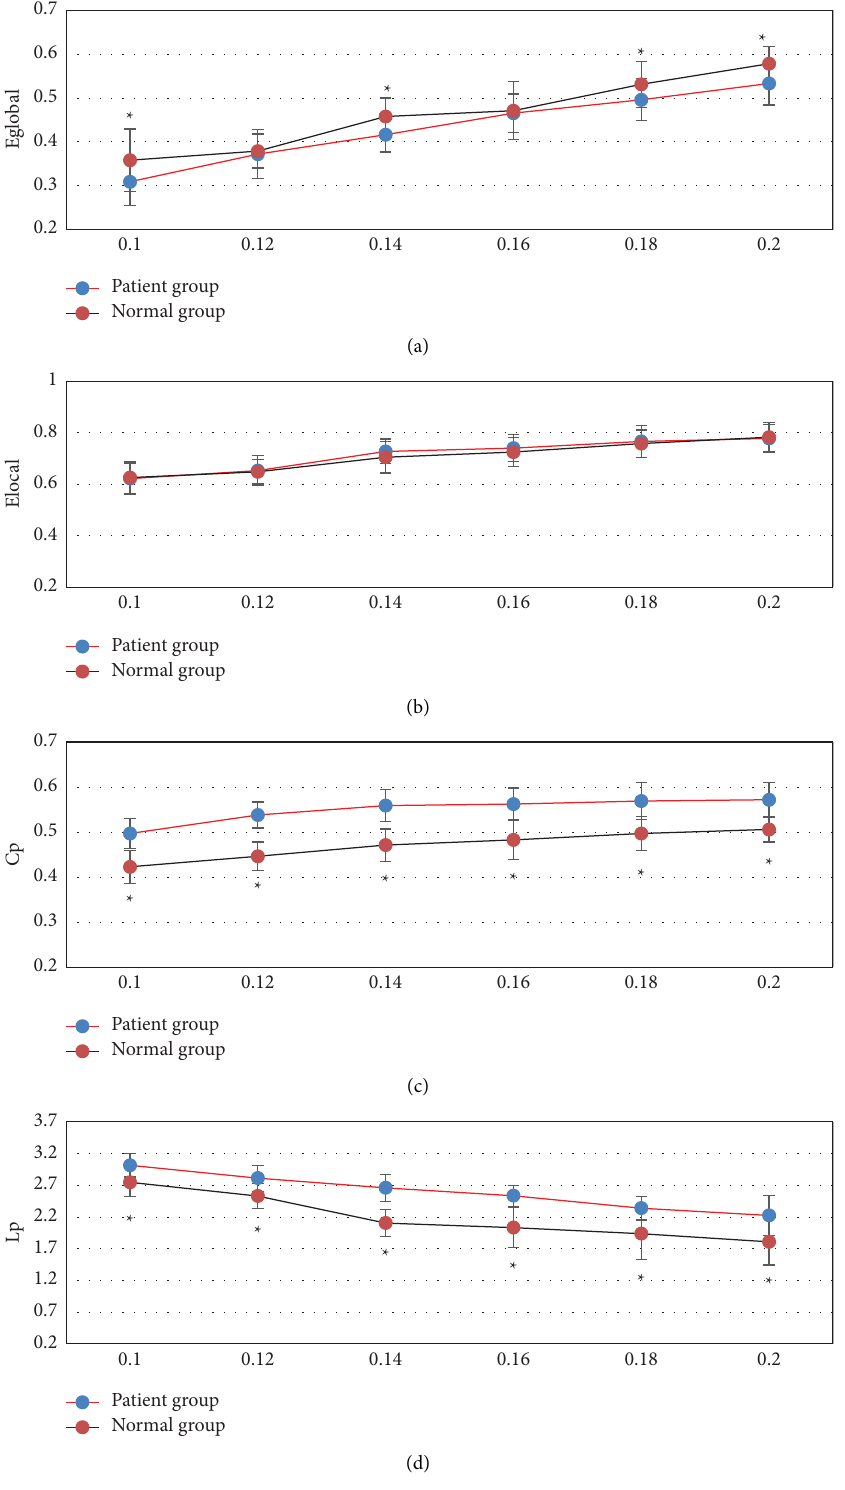
Figure 1: Comparison of the fMRI parameters E global , E local , C p , and L p between the two groups. (a–d) represented E global , E local , C p , and L p , respectively. ∗ represents that the fMRI parameters of the patient group, including E global , C p , and L p, were signifcantly diferent from those in the normal group ( P < 0 .